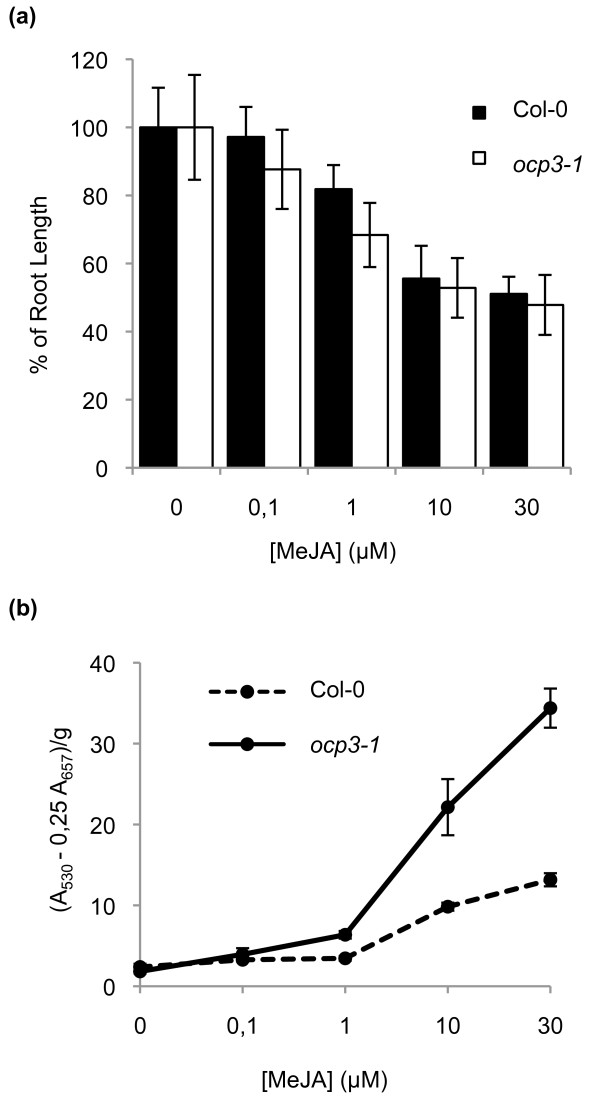
Mutant ocp3-1 is not JA-insensitive. Effect of JA on Col-0 and ocp3-1 plants. Plants were grown in MS plates supplemented with indicated MeJA concentrations during 10 days. Root growth inhibition was represented as the difference to the control (0 μM MeJA) treatment. (a) Root growth inhibition. Bars represent the JA-induced rooth-growth inhibition in Col-0 (black bars) and ocp3-1 plants (white bars). (b) Anthocyanin accumulation. Lines represent the anthocyanin accumulation in the same experiment. Anthocyanin quantification was performed by a spectrophotometric method. Error bars represent standard deviation (n = 5 plates). The experiments were repeated three times with similar results.